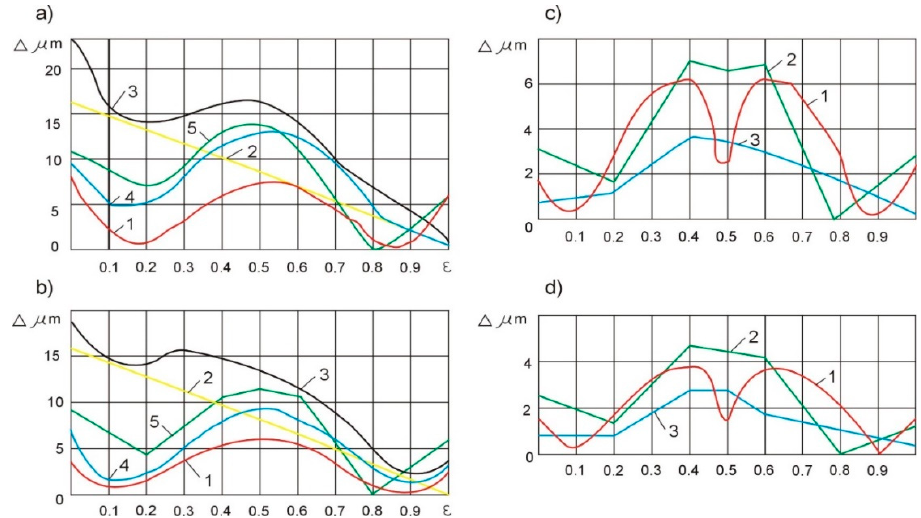
Figure 7. Shaft cylindricity errors: when adjusting the susceptibility of the technological systems: ( a ) for d = 8 mm and ( b ) for d = 14 mm; when adjusting the susceptibility of the technological systems: ( c ) for d = 8 mm and ( d ) for d = 14 mm.